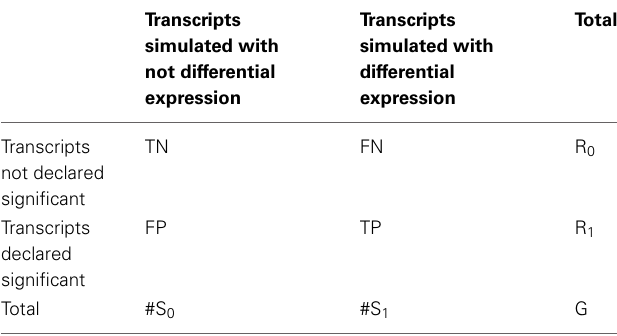
Table 1 | Classification rule to compute false and true positive rates.